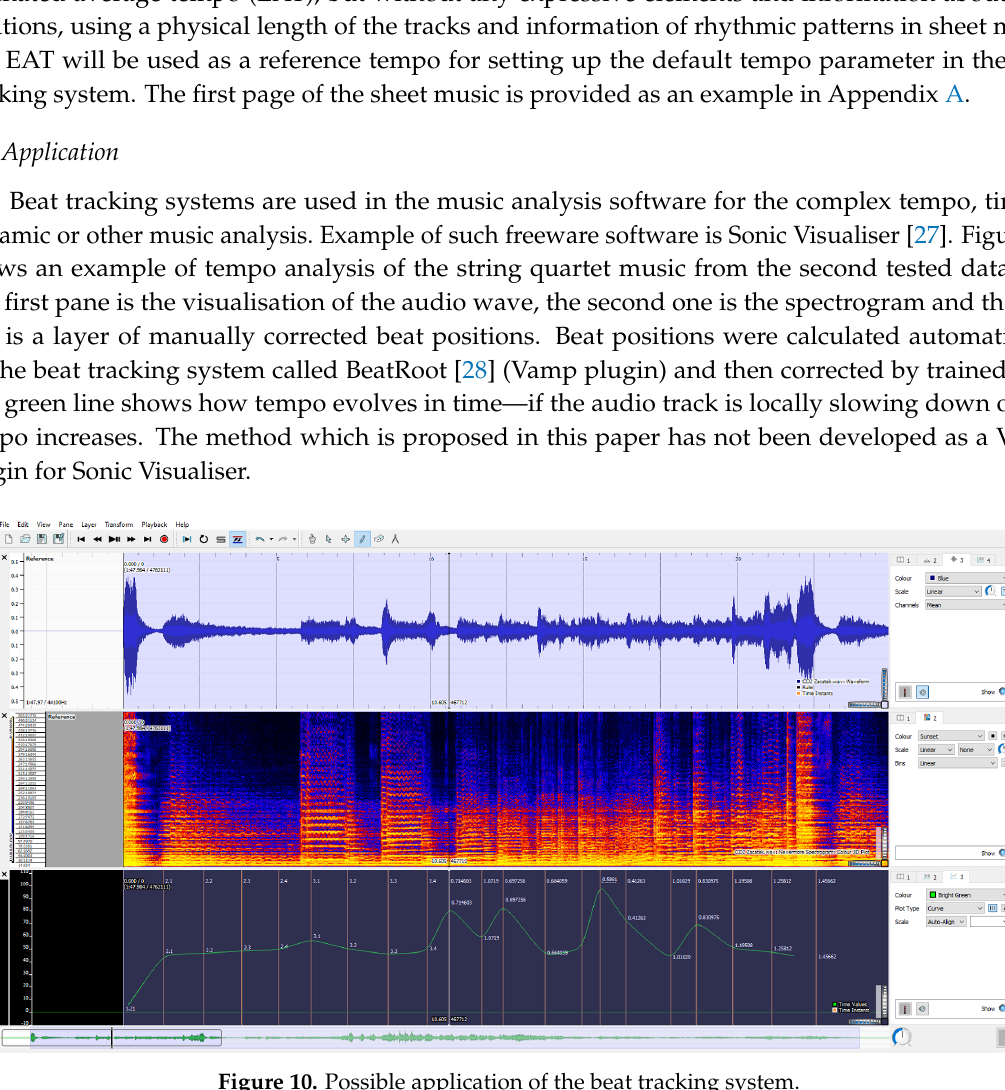
Figure 10. Possible application of the beat tracking